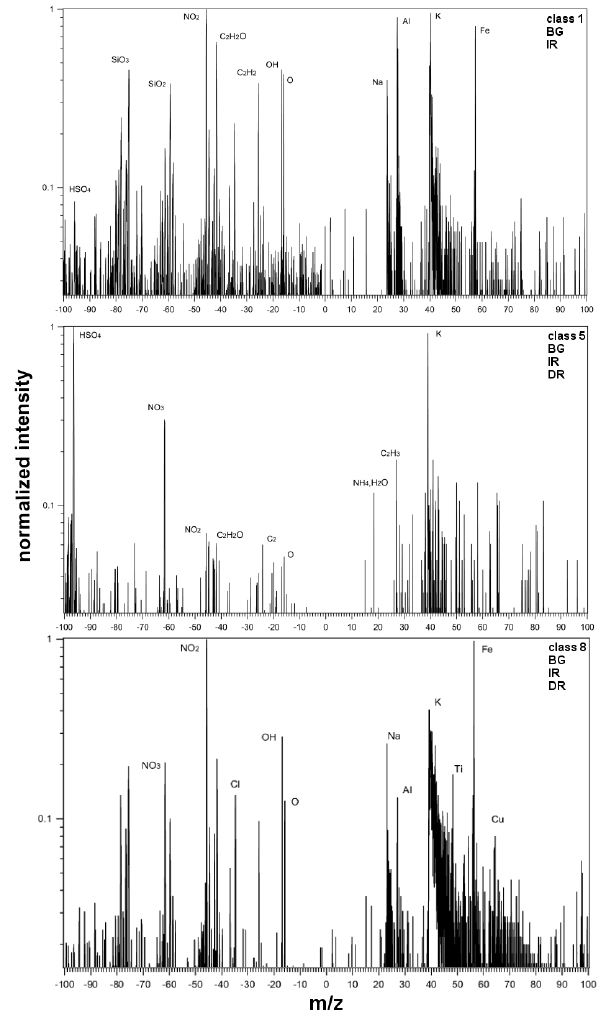
Figure 6 Fig. 6. Particle spectra representative of ATOFMS class 1 (mineral dust or fly ash), 5 (biomass burning) and 8 (metallic). Presence of each type in the background aerosol (BG), ice residues (IR) and droplet residues (DR) is